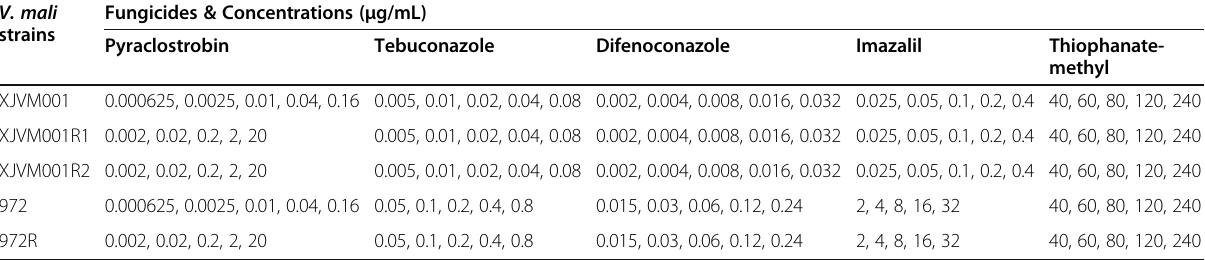
Table 5 Fungicides and concentrations used to analyze cross-resistance between pyraclostrob and other fungicides in pyraclostrobin-sensitive and pyraclostrobin-resistant Valsa mali isolates V.